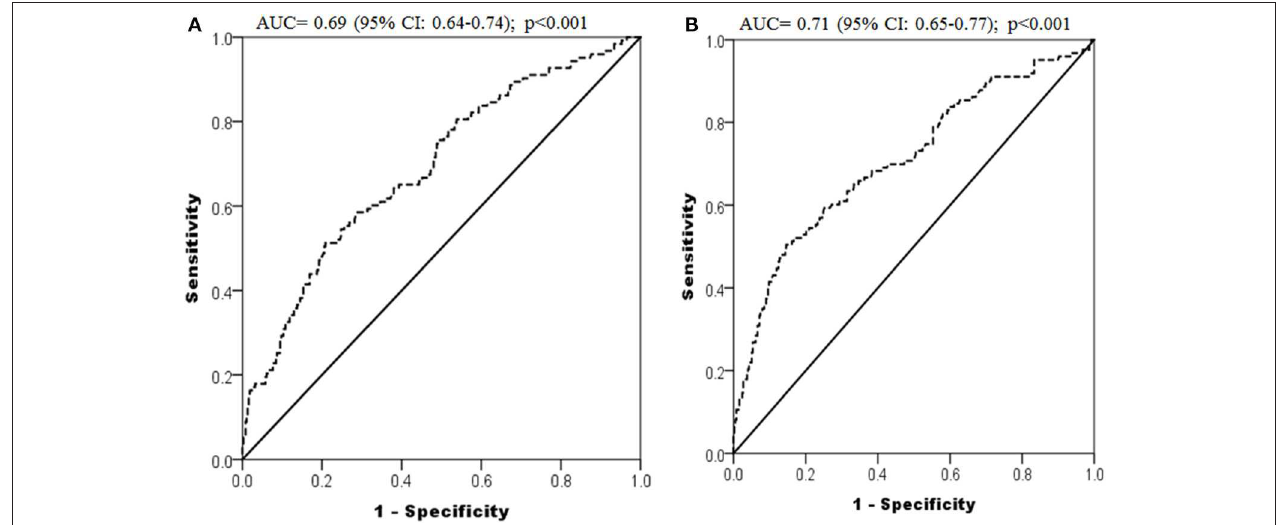
FIGURE 3 | ROC curves depicting predictive power of first trimester fasting glucose (A) and triglycerides (B) for development of